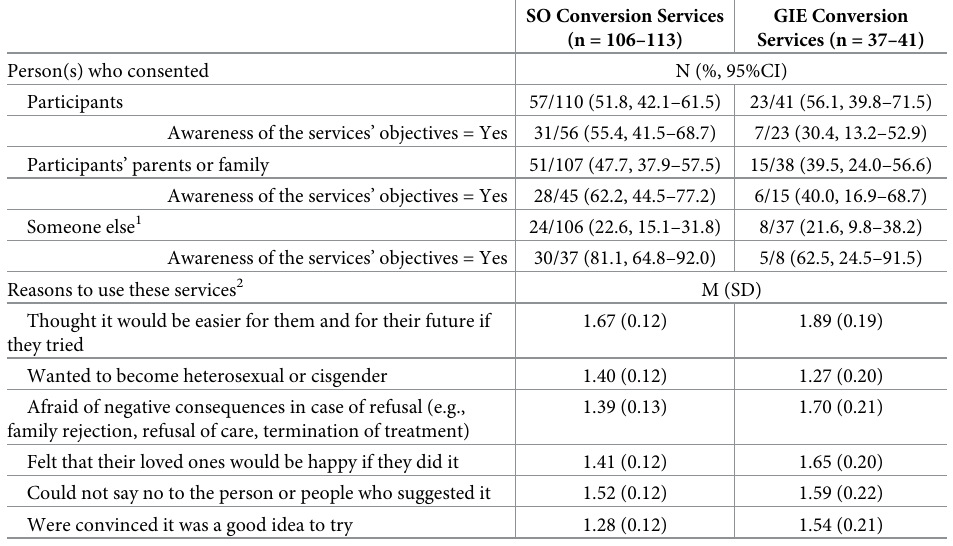
Table 8. Informed consent to and reasons for SOGIE conversion service